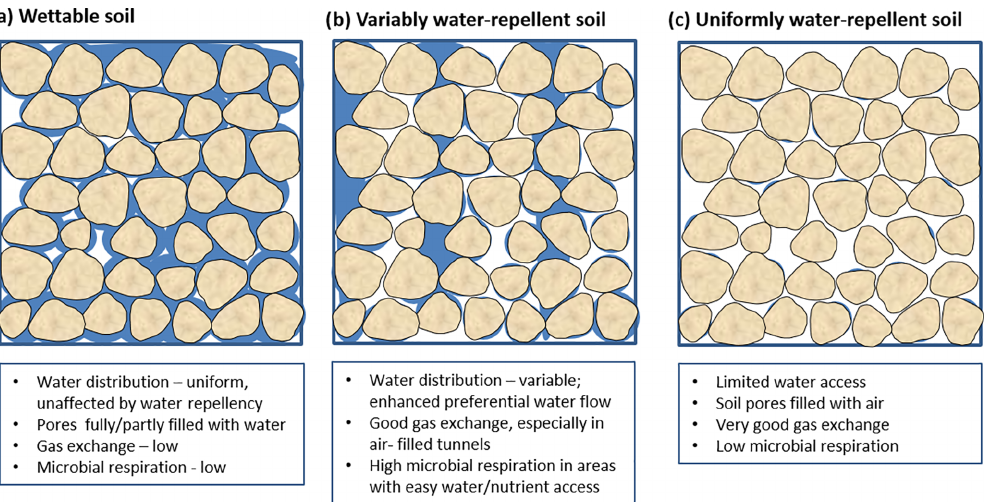
Figure 6. Theoretical framework of soil water distribution at three different conditions of SWR and its potential effects on soil CO 2 produc- tion and